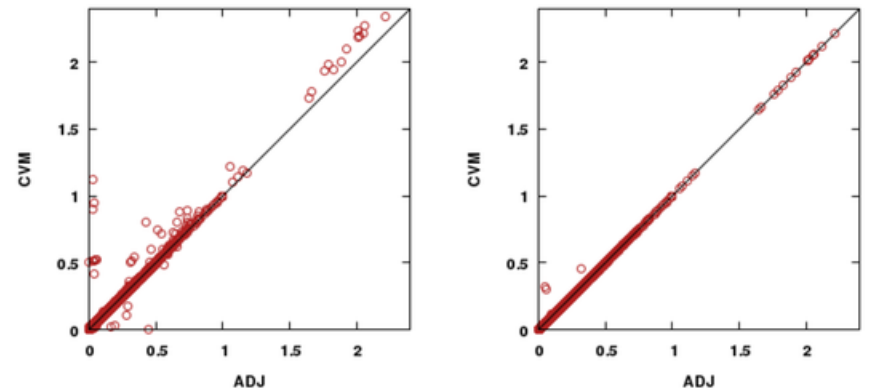
Figure 3. Evaluation of all aerosol subprocesses with the ADJ (adjoint) against the CVM (complex variable method) sensitivities of the final concentrations of an accumulation-mode aerosol species ASO4J (µgm − 3 ) with respect to the initial concentrations of the Aitken-mode aerosol species ASO4I (µgm − 3 ) from a 1d test run: left, original results; right, ISORROPIA branches set consistent between the CVM and the ADJ. The perturbation size for the CVM is 1.E-12.